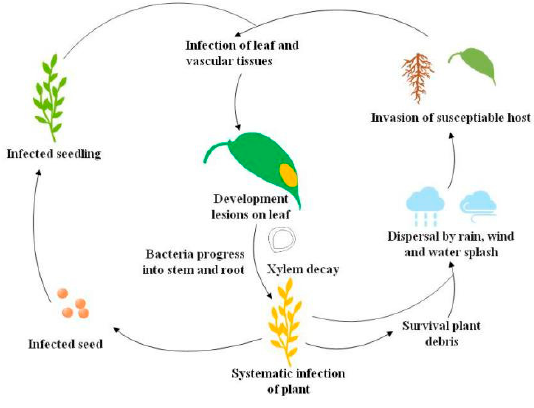
Figure 1. Life cycle of the black rot pathogen Xanthomonas campestris pv. campestris ( Xcc ) [5].